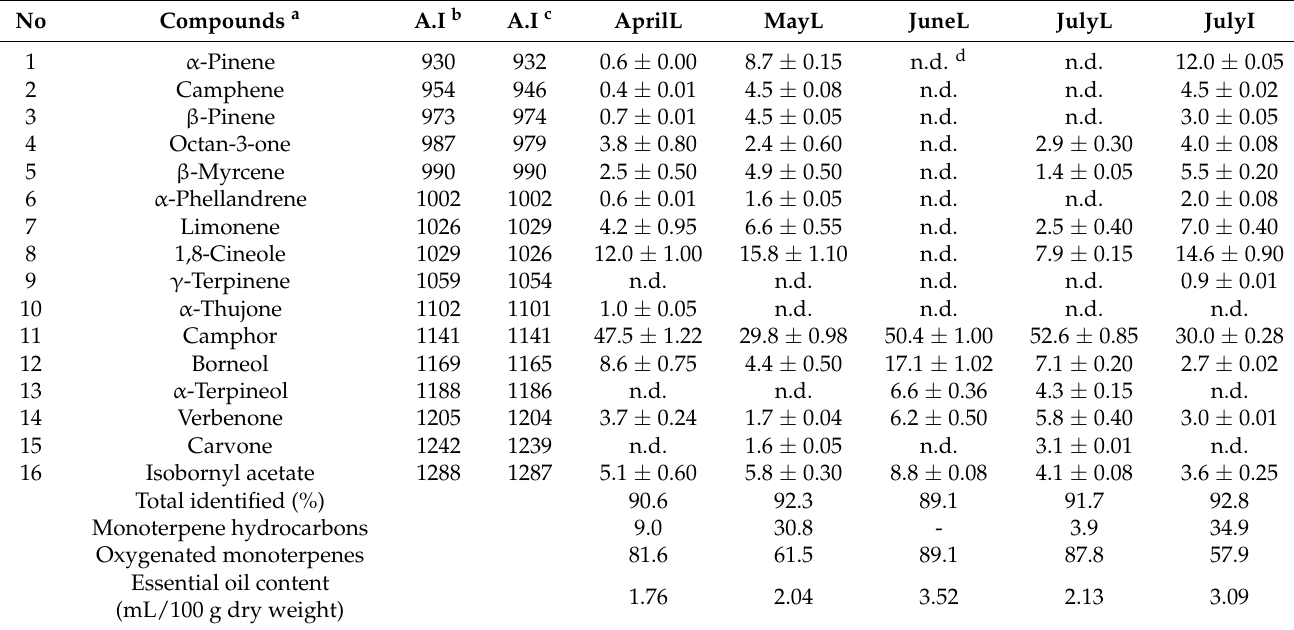
Table 3. Qualitative and quantitative composition of the Essential oils from S. rosmarinus .